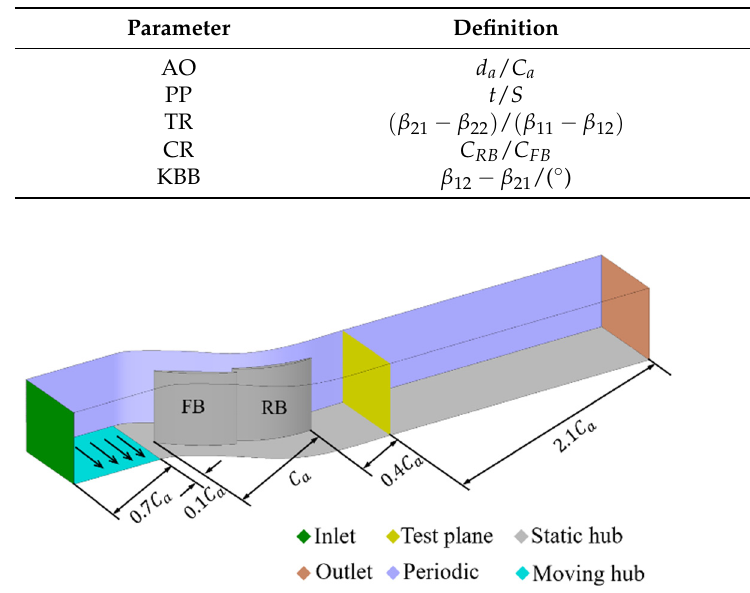
Figure 2. Computational domain of the tandem cascade.